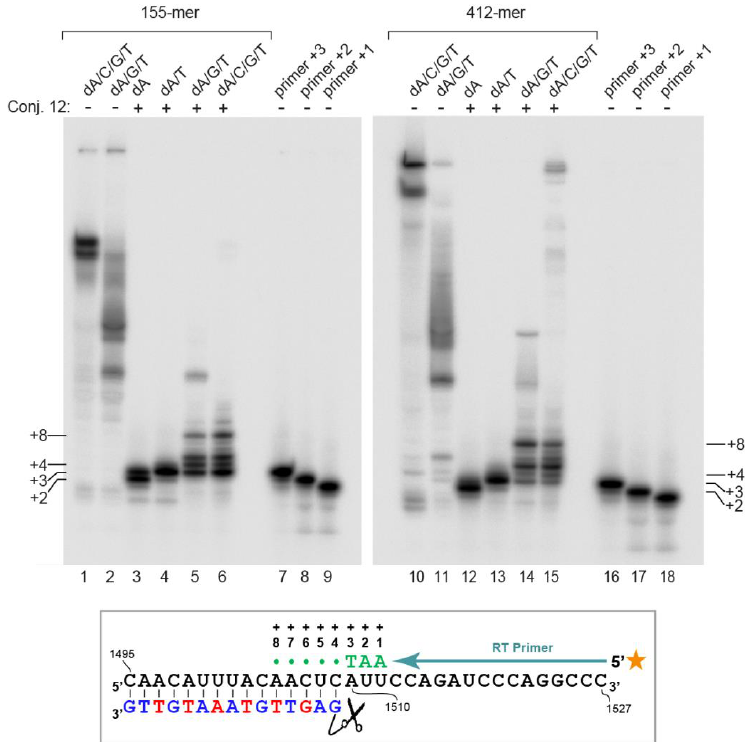
Figure 5. Primer extension assays to map the sites of cleavage on the RNA 155-mer 14 and 412-mer 15 catalyzed by conjugate 12 . Here, dA/C/G/T: Reverse transcription (RT) in the presence of 0.5 mM of each dNTP; dA/G/T: RT without dCTP; dA/T: RT without dCTP and dGTP; dA: RT in the presence of 0.5 mM dATP only. Lanes primer +1, +2, and +3: 5 (cid:48) - 32 P-end-labeled DNA oligonucleotides mimicking the +1, +2, and +3 extension products of the reverse transcription reaction (5 (cid:48) -GGGCCTGGGATCTGG A -3 (cid:48) , 5 (cid:48) -GGGCCTGGGATCTGG AA -3 (cid:48) , and 5 (cid:48) -GGGCCTGGGATCTGG AAT -3 (cid:48) ). Note that in Lanes 3 (only dATP present), we saw not only the expected +2 extension product, but also a +3 product, suggesting that the reverse transcriptase added an additional untemplated nucleotide. The scheme at the bottom illustrates the target RNA region (black letters), the complementary conjugate 12 (blue: DNA residues, red: LNA residues), the chemical nuclease as scissors, the RT primer as a cyan arrow (the 5 (cid:48) -32P label indicated by the orange asterisk), and the first three primer extension products as green letters and the longer ones as green